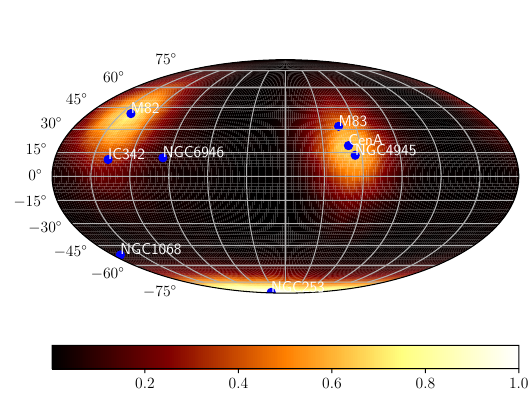
Figure 5: Skymap of the injected EGCR flux following the distribution of the 10 brightest galaxies from the star- burst catalogue, with their relative contributions matched to their given brightness, as well as rigidity- and distance- dependent